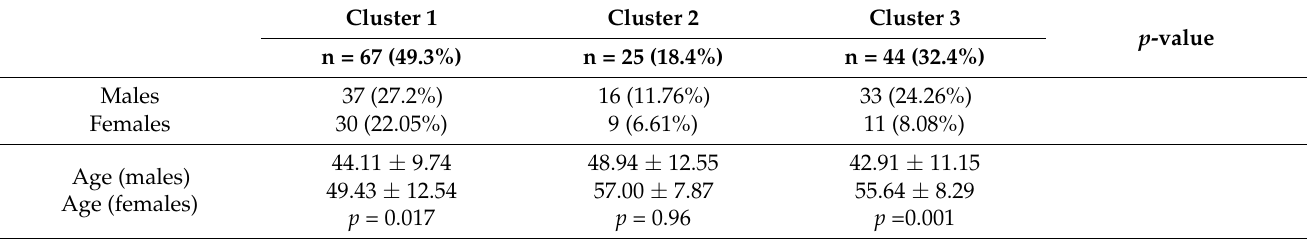
Table 4. One-way analysis of variance (ANOVA)